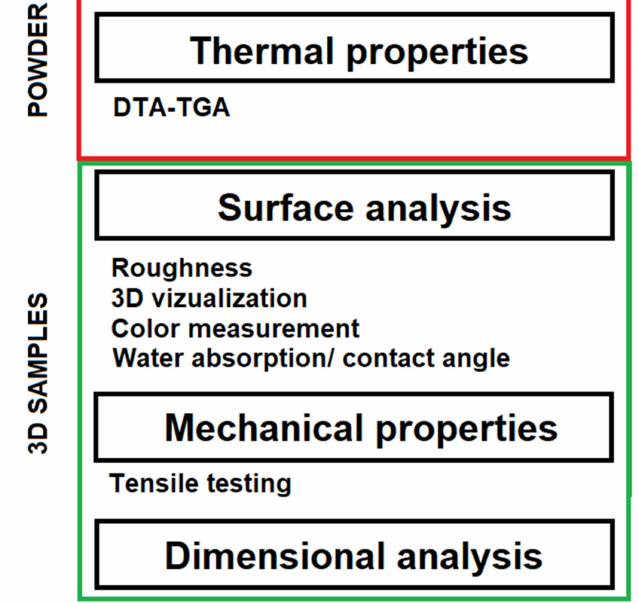
Figure 2. Scheme of material